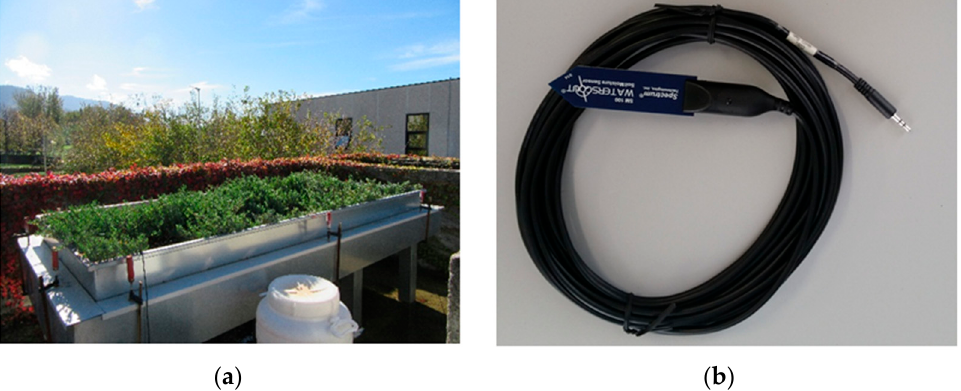
Figure 1. ( a ) Green Roof test bed within the University of Salerno Campus; ( b ) FDR sensor installed at the experimental site.